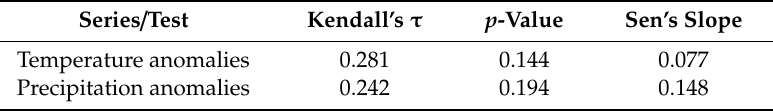
Table 8. Summary of data obtained from the Mann–Kendall test.